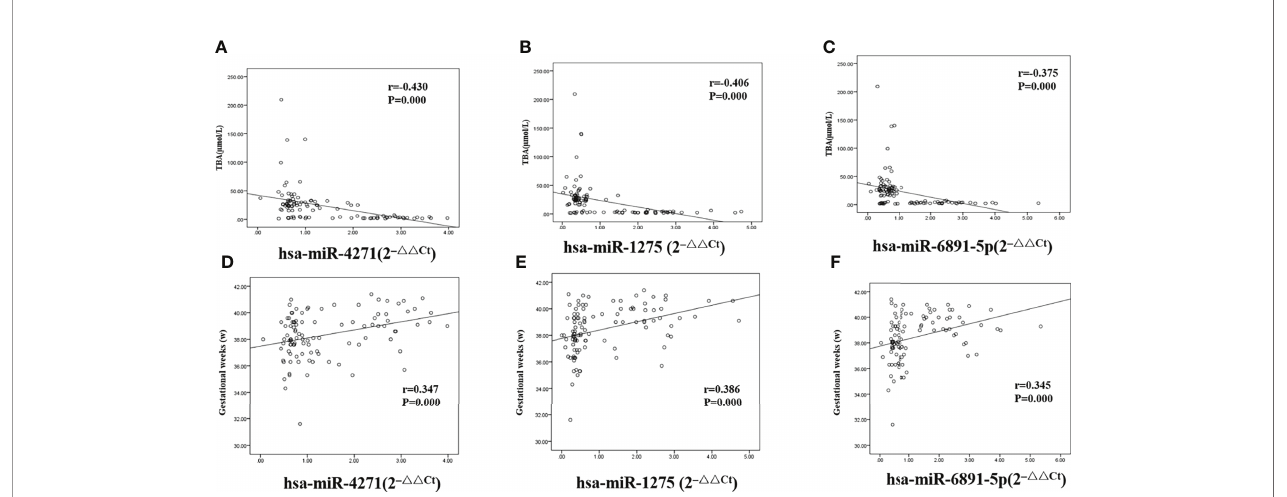
FIGURE 7 | Correlations between serum levels of exosome miRNA and levels of total bile acid and gestational week (delivery) in pregnant women with ICP. (A) hsa- miR-4271 and TBA (r = − 0.430 and P = 0.000); (B) hsa-miR-1275 and TBA (r = − 0.406 and P = 0.000); (C) hsa-miR-6891-5p and TBA (r = − 0.375 and P = 0.000); (D) hsa-miR-4271 and gestational weeks (r = 0.347 and P = 0.000); (E) hsa-miR-1275 and gestational weeks (r = 0.386 and P = 0.000); (F) hsa-miR-6891-5p and gestational weeks (r = 0.345 and P =